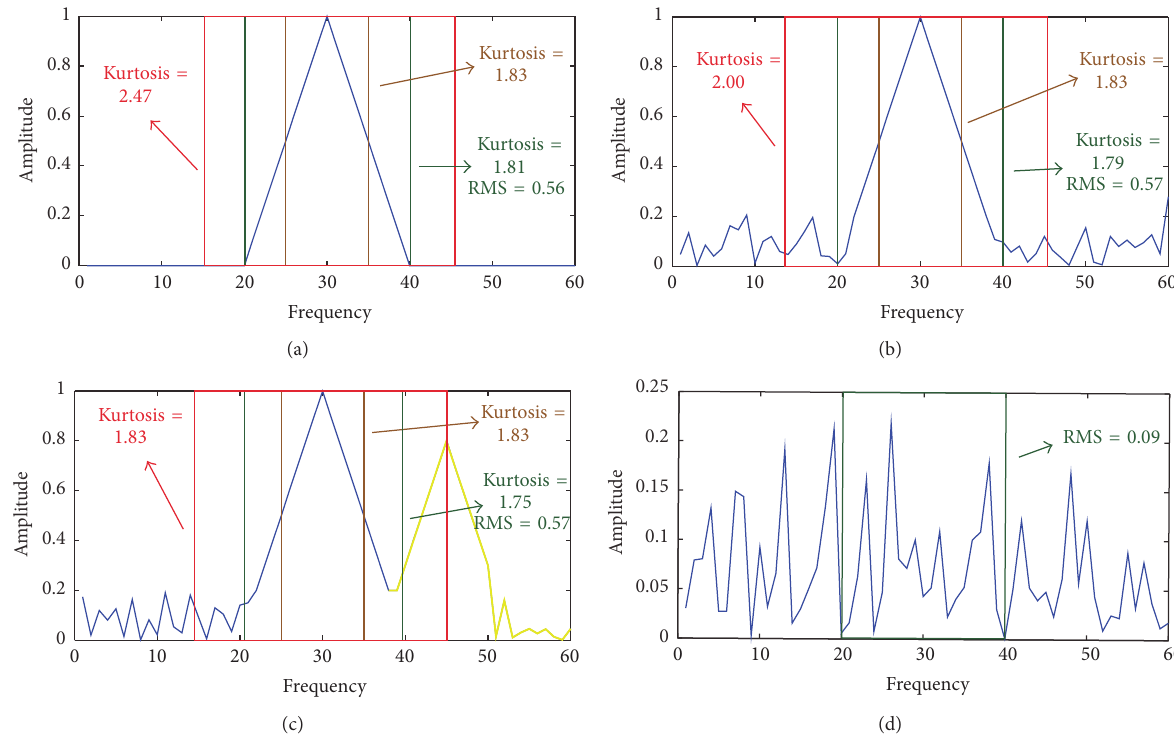
Figure 5: Illustration of the intelligent bandwidth selective principle: (a) single spectral peak; (b) single spectral peak with background noise; (c) single spectral peak with a parasite peak and background noise; (d) background noise.